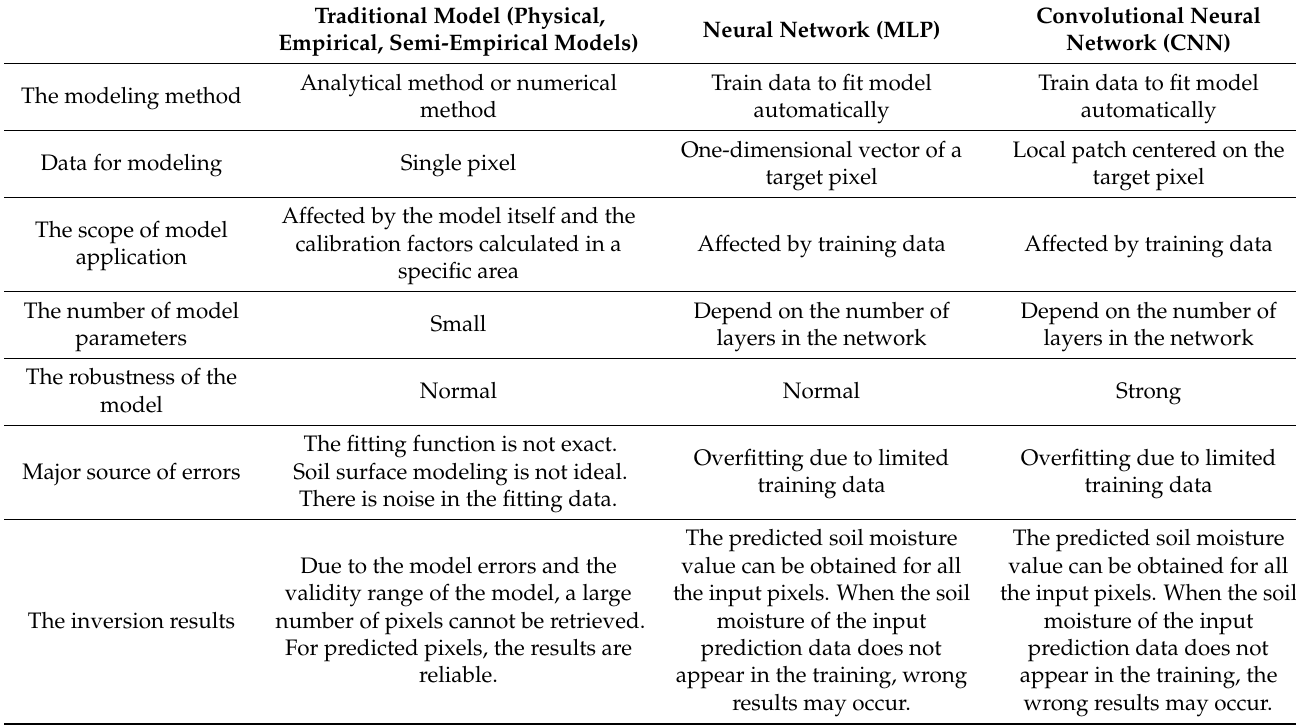
Table 1. Differences between traditional, neural network, and convolutional neural network models. Traditional Model